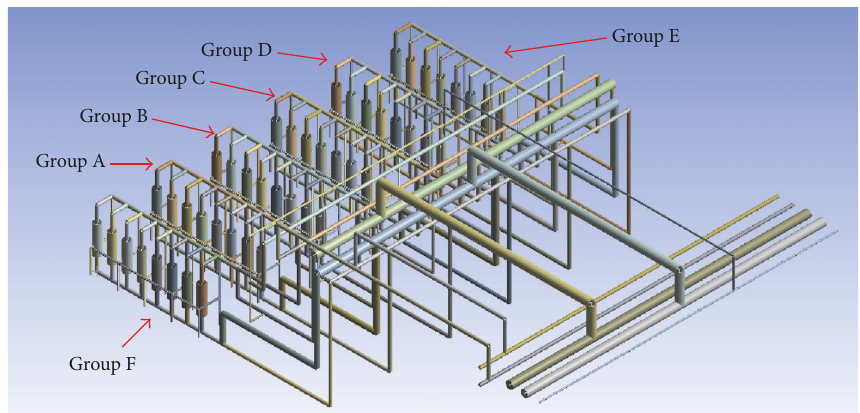
Figure 2: A filter and piping system model.